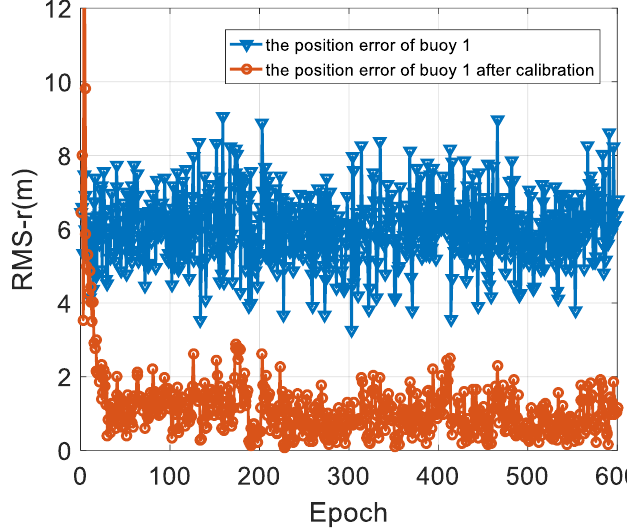
Figure 7. The positioning error analysis result of buoy 1.